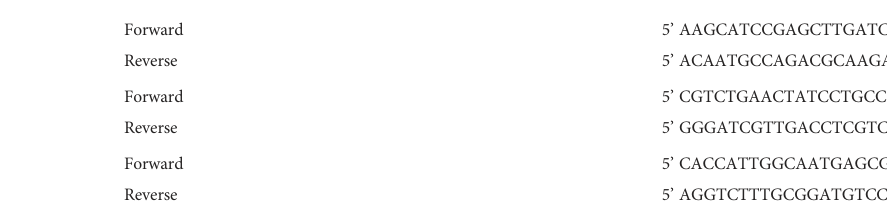
TABLE 1 Primer sequences used for qPCR